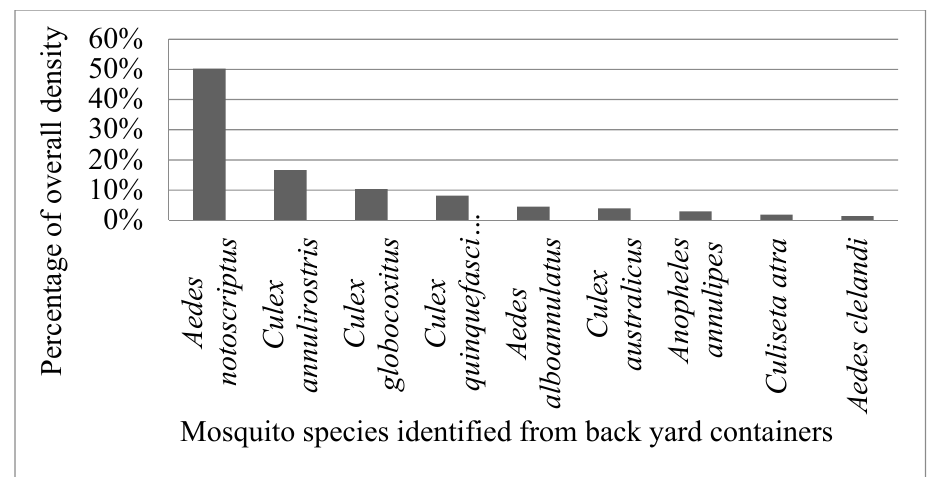
Figure 2. Overall percentage density of mosquitoes from larvae collected from backyard containers across the study area.